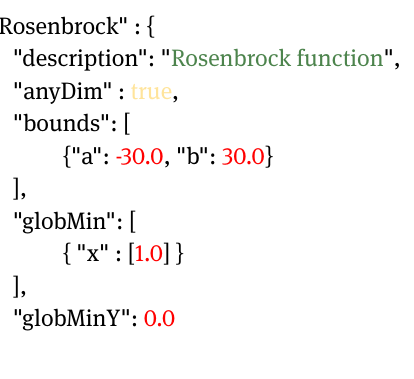
Figure 2: Meta description for the Rosenbrock benchmark in JSON